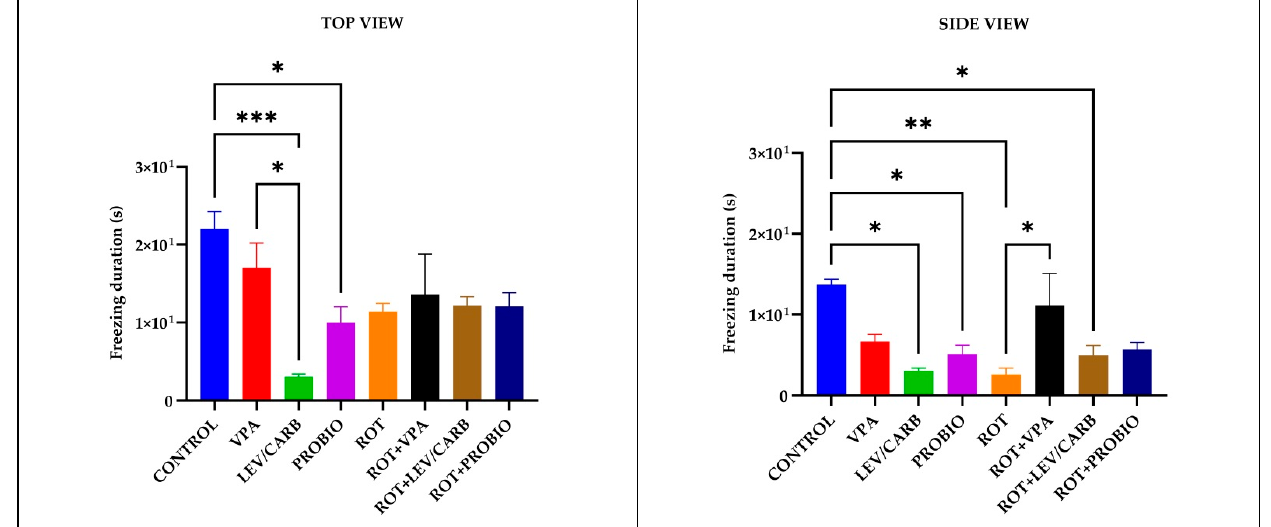
Figure 4. Episodes of inactivity (s) patterns in studied Danio rerio ( n = 5) groups (*— p < 0.05; **— p < 0.005; ***— p < 0.0005; values expressed as mean with SEM followed by Tukey test).